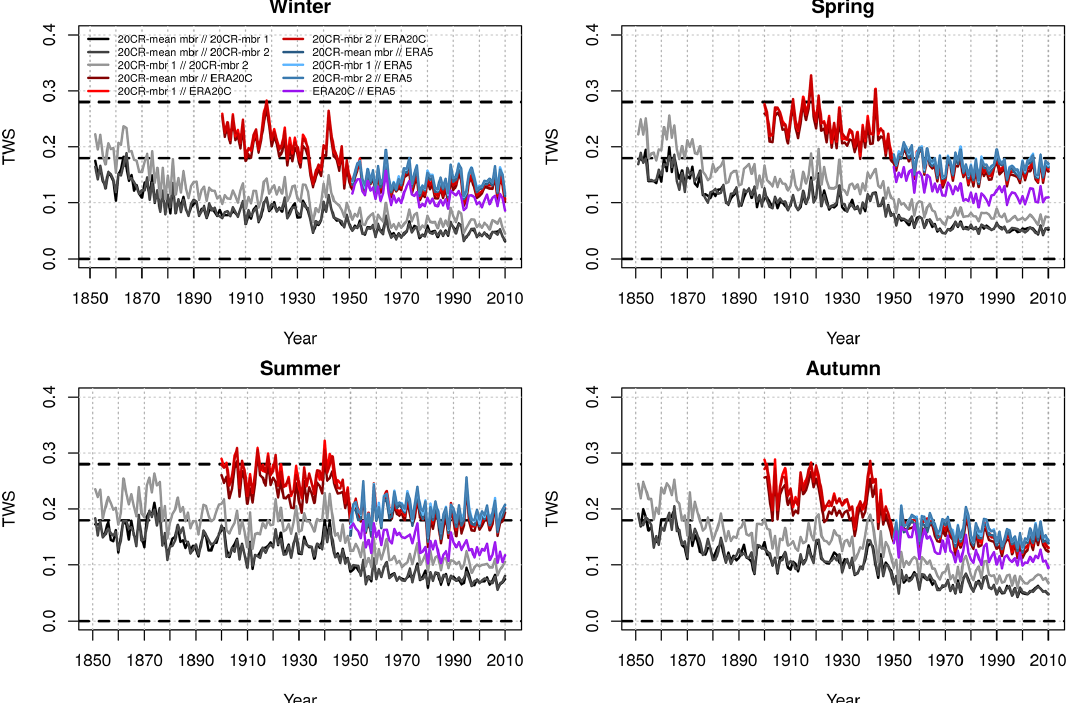
Figure 3. Evolution of the seasonal mean Teweles–Wobus score (TWS) between the geopotential height fields from the different reanalyses over the period 1851–2010. The dotted black lines show respectively the minimum TWS value (0) – when geopotential shapes are identical – and, for reference, the TWS between day D and two other days in Fig. 2a – TWS = 0 . 18 and TWS = 0 . 28 – which corresponds to the 69th percentile of celerity for the period 1950–2010 using